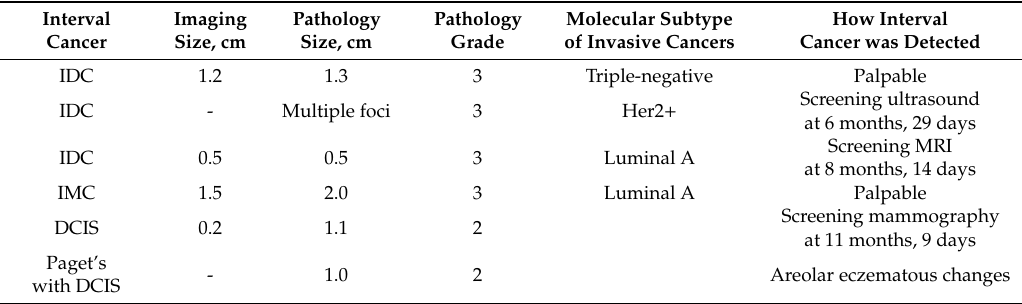
Table 5. Features of interval